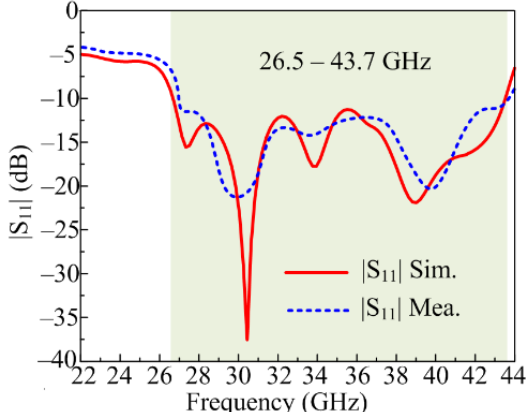
Figure 5. Comparison among simulated and experimental |S 11 | results.